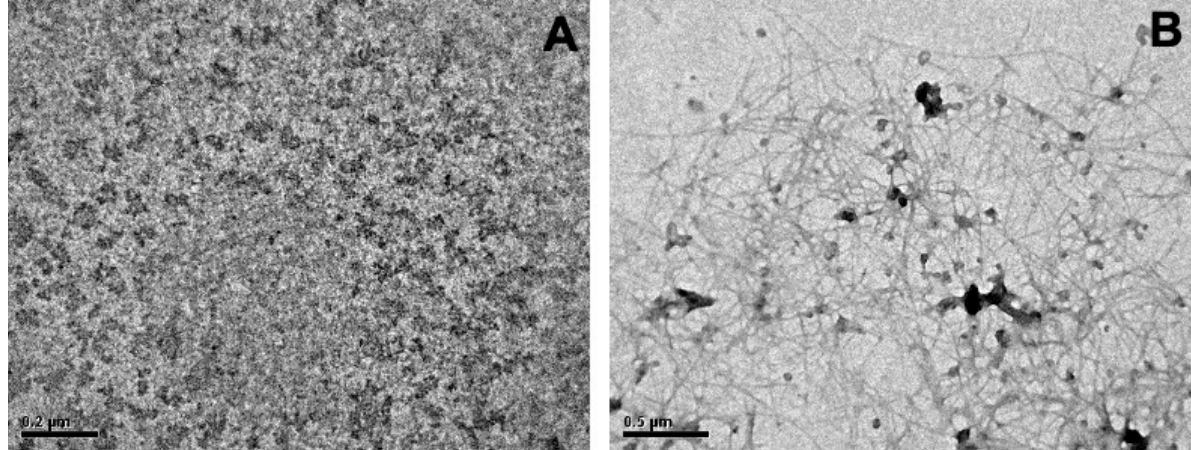
Figure 2. Ultrastructure of A β (1-42) oligomers and fiber species. ( A ) Transmission electron micrograph of A β (1-42) oligomers (80 μ M) obtained after 24 h of aggregation process with a spinning bar at 400 rpm and ∼ 20 °C (room temperature). ( B ) Micrograph of A β (1-42) fibers obtained after the incubation of the oligomeric species for 24 h at 37 °C without agitation.